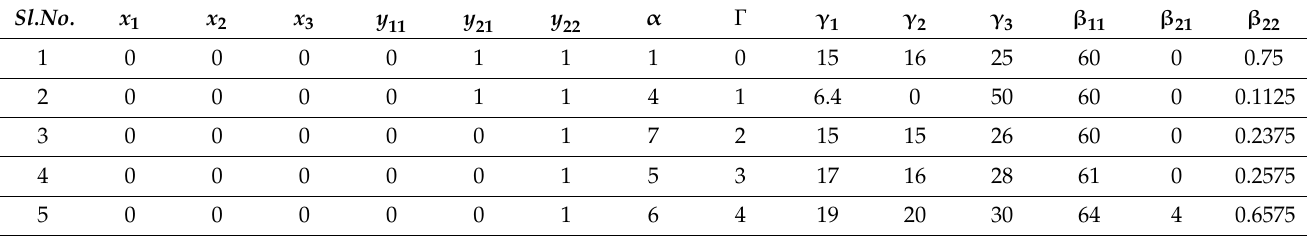
Table 4. Five Experiments for comparison